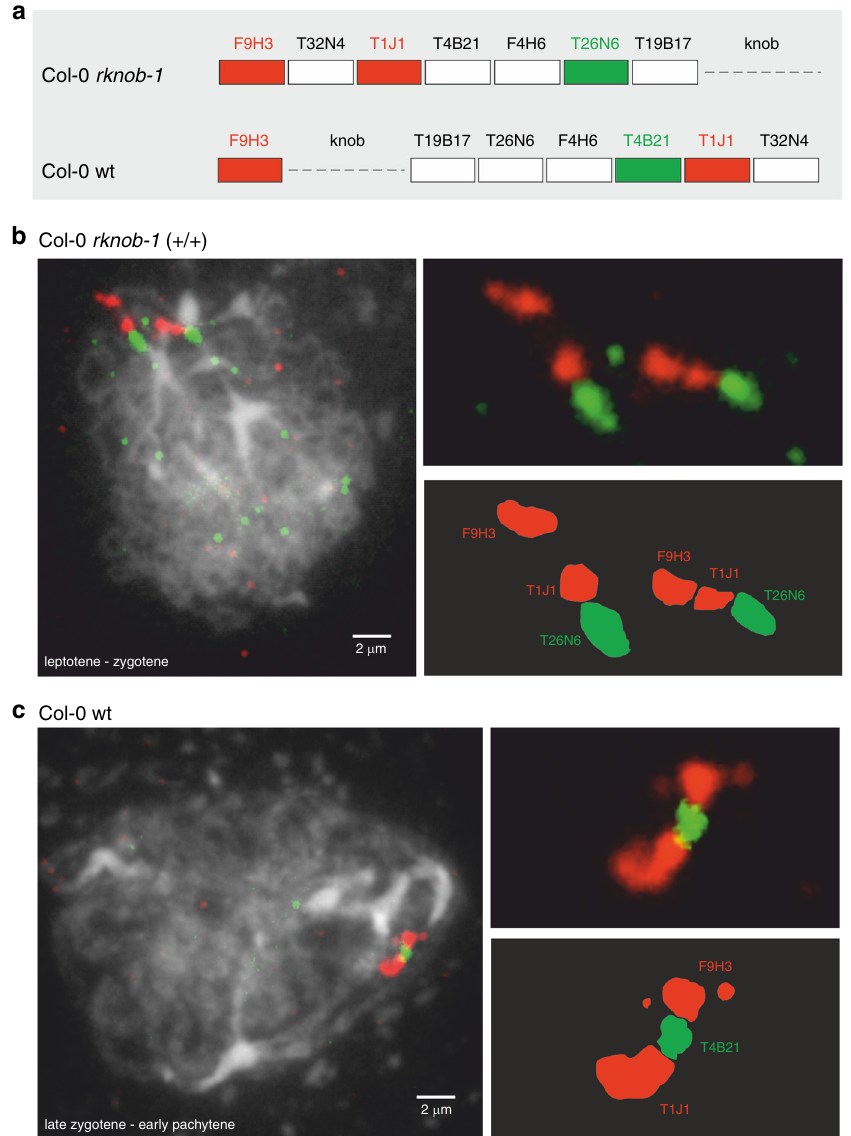
Fig. 2 Fluorescence in situ hybridization to Col-0 WT and the homozygous rknob-1 . a Schematic overview of the expected fl uorescence patterns of inversion BACs relative to the reference F9H3, which maps distal from the knob hk4S. Two independent FISH experiment were performed for both Col-0 and rknob-1. In both cases the same fl uorescence pattern were obtained as shown in the fi gure as well as in the Source Data fi le. b Early zygotene meiocyte of rknob-1 showing red-red-green signals in both homologues of chromosome 4. The length of the scale bar is 2 µ m. c Prophase I meiocyte of Col-0 WT with red-green-red signals. The length of the scale bar is 2 µ m. Source data are provided as a Source Data fi